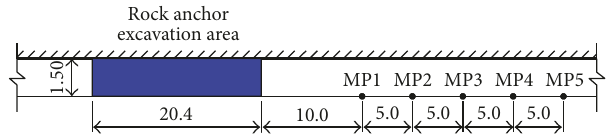
Figure 7: The schematic diagram of measuring point layout of blast vibration velocity (unit: